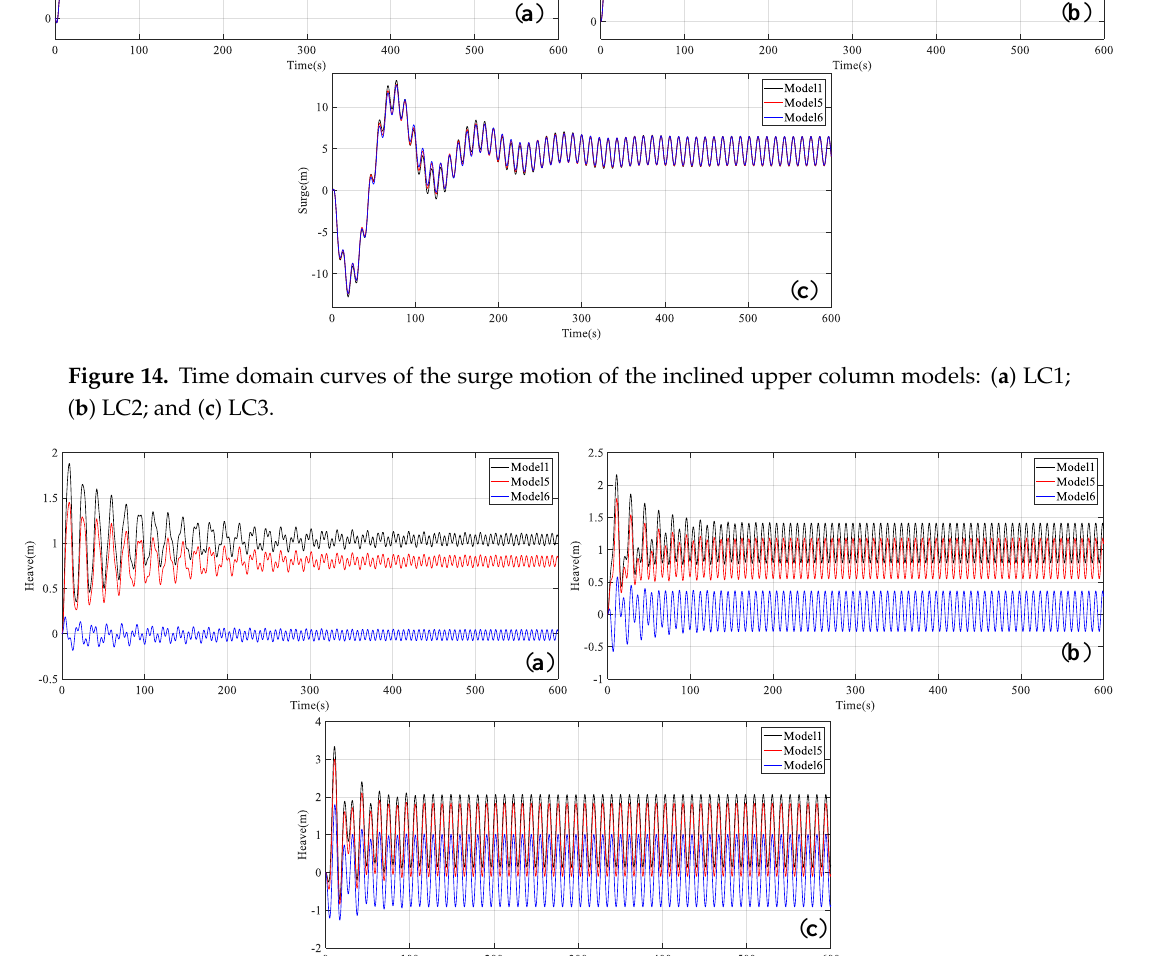
Figure 15. Time domain curves of the heave motion of the inclined upper column models: ( a ) LC1; ( b )